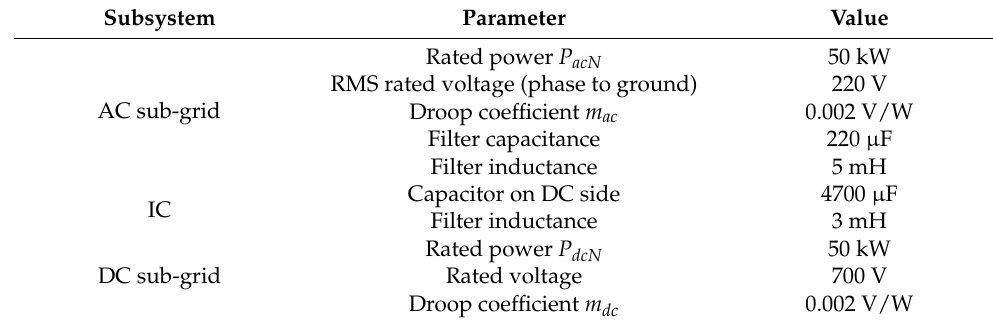
Table 2. Main parameters of